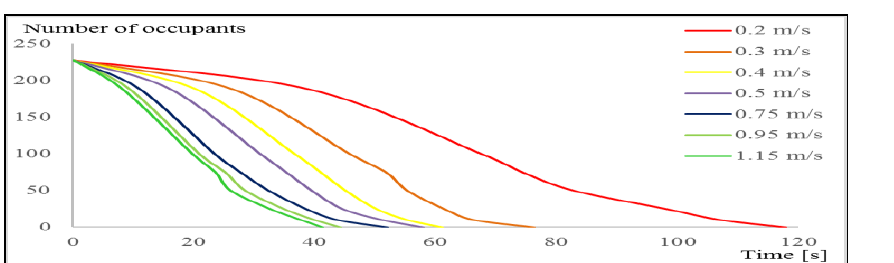
Figure 11 – Simulation results for the first case of the second scenario Рис. 11 – Результаты моделирования первого случая по второму сценарию